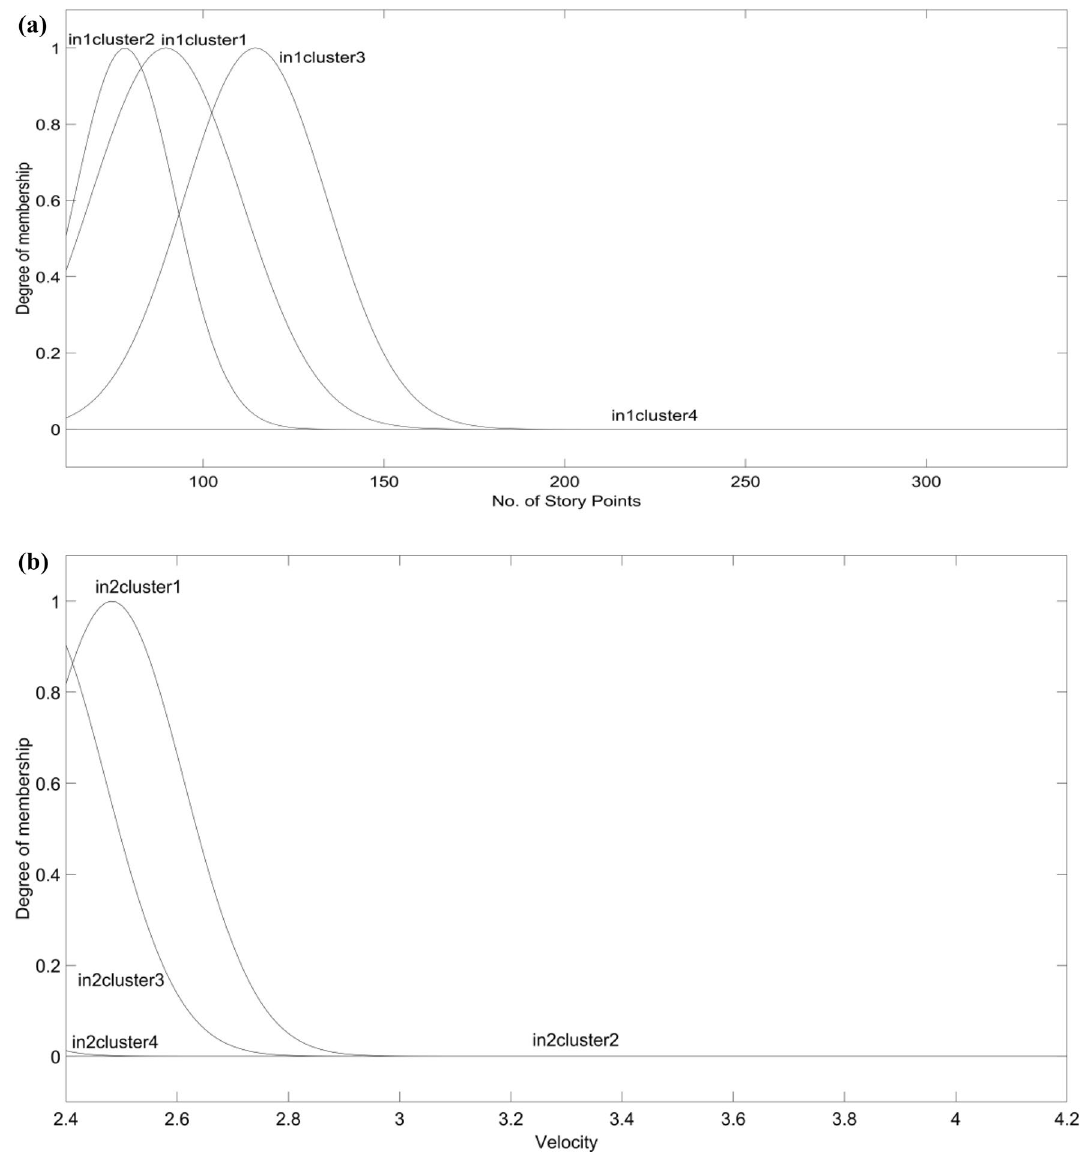
Figure 4. ( a ) Membership function for Input1 i.e., No. of Story Points. The x-axis and y-axis represent “No. of Story Points” and membership values of input1 respectively. The set of four unique MFs created are represented as curves (in1cluster1, in1cluster2, in1cluster3, in1cluster4) in the figure. ( b ) Membership function for Input2 i.e., Velocity. The x-axis and y-axis represent “Velocity” and membership values of input2 respectively. The set of four unique MFs created are represented as curves (in1cluster1, in1cluster2, in1cluster3, in1cluster4) in the figure. The curves are overlapped due to the minute values of “Velocity” which is ranging from 2.4 to there is a strong positive link between the story point, velocity, and the estimated work necessary to develop the software, with little changes in one causing considerable changes in the other. The lowest MMRE and highest PRED (15%) signify the efficacy of ANFIS-EEBAT over other techniques. Various techniques are employed on ZKmS dataset for comparative analysis. Standard ANFIS uses hybrid (Back- propogation and Least Square Regression (LSE)) learning for training. In ANFIS-GA, ANFIS-PSO and ANFIS- BAT the default learning algorithm of ANFIS have been replaced by Genetic Algorithm (GA), Particle Swarm Optimization (PSO), and BAT, respectively. GA, PSO and BAT are well known nature inspired meta-heuristic algorithms. Their innate ability of finding optimal solutions provides valuable feedback in exploration and com- parison. Random Forest is an ensemble learning method which performs mean prediction of singular trees for estimation. Radial Basis Function (RBF) kernel-based Support Vector Regressor (SVR) has been used. Stochastic Gradient Boosting (SGB) has also been employed for estimation. It is a well-known algorithm which inculcates randomness and variation in boosting which increases robustness in learning complex data.